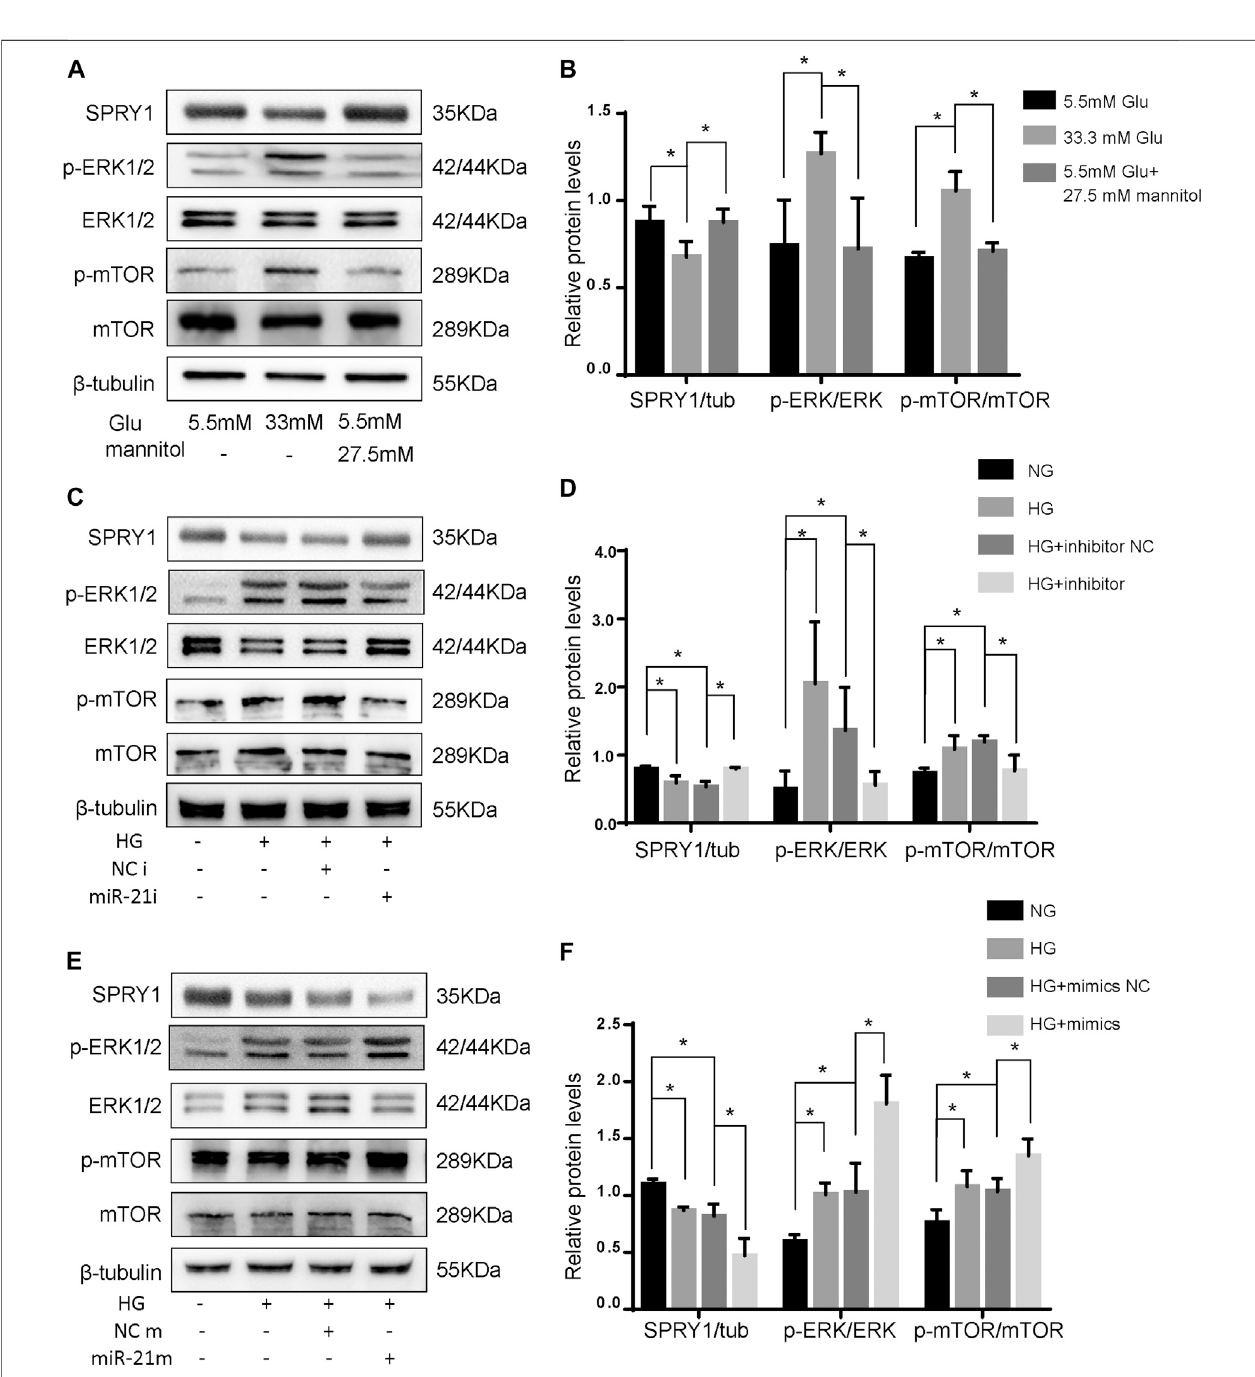
FIGURE5| miR-21regulatesautophagyviaSPRY1/ERK/mTORpathwayunderHG. (A) RepresentativeWBimagesofSPRY1, p -ERK,ERK, p -mTOR,andmTOR in H9c2 cells (B) Quanti fi cation of SPRY1, p -ERK, ERK, p -mTOR, and mTOR protein levels. * p < 0.05. (C, E) Representative WB images of SPRY1, p -ERK, ERK, p -mTOR, and mTOR in H9c2 cells. (D, F) Quanti fi cation of SPRY1, p -ERK, ERK, p -mTOR, and mTOR protein levels. * p < 0.05. NG, normal glucose; HG, high glucose (33 mM glucose); miR-21i, miR-21 inhibitor; miR-21m, miR-21 mimics; NCi, miR-21 inhibitor negative control; NCm, miR-21 mimic negative control.